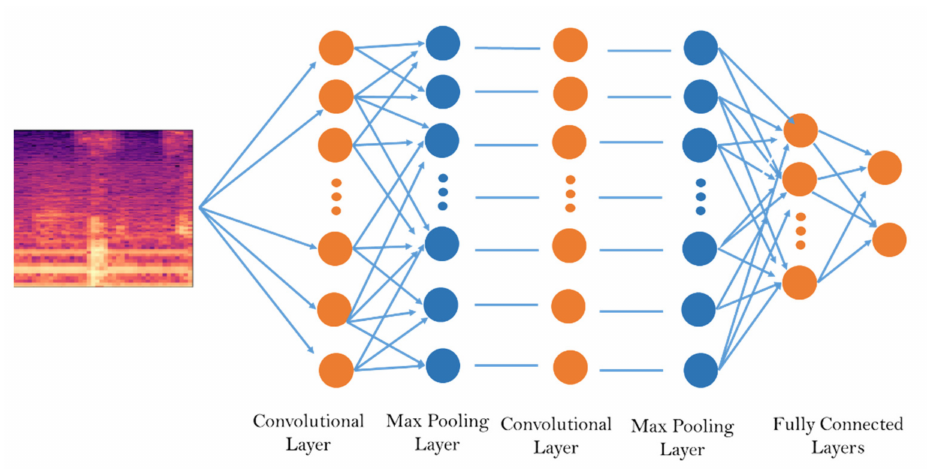
Figure 12. Hit sound spectrogram.